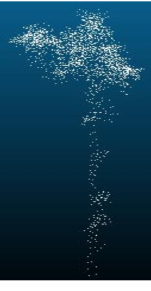
Figure 13. The UAVLS data of the individual tree are